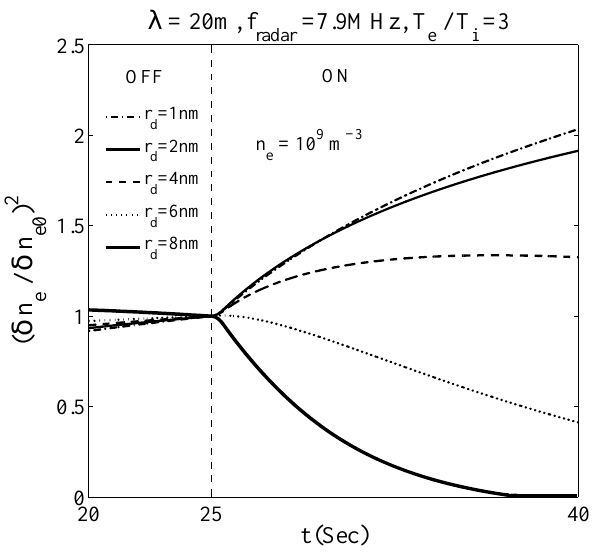
4 Temporal behavior after pump turn-off The physics after turn-off of the radio wave pump is different than the physical process after turn-on. After the radio wave is turned-off, the electron temperature returns back to its ini- tial value before the turn-on and the ion irregularities start to diffuse out. The ion current onto the dust will be domi- nant and ions drag along the electrons while diffusing back. Therefore the total current onto the dust can be approximated ent is steeper and has larger amplitude at smaller irregularity scale sizes. Therefore, ions drag along more electrons dur- ing the diffusion process and the turn-off overshoot is larger for higher radar frequencies. The computational model pre- dicts an enhancement in electron irregularity amplitude for τ diff /τ chg < 1 which means the electron-ion ambipolar diffu- sion time is less than dust particle charging time. Figure 4 shows the temporal evolution of electron